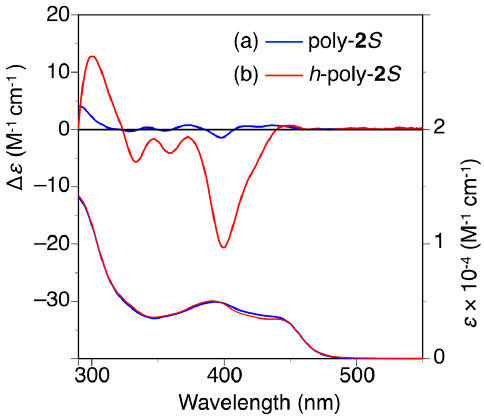
Figure 2. CD and absorption spectra of poly- 2 S ( a ) and h -poly- 2 S ( b ) in N , N -dimethylformamide (DMF) at 25 °C. h -Poly- 2 S was obtained by annealing poly- 2 S in DMF at 120 °C for 2 h. The poly-( 2 S x - co - 3 1 − x )s were converted to the corresponding h -poly-( 2 S x - co - 3 1 − x )s with predominantly one-handed helical conformations in the same way by annealing the corresponding DMF solutions at 120 °C for 2 h. Figure 3 shows the CD and absorption spectra of the h -poly-( 2 S x - co - 3 1–x )s in DMF at 25 °C together with those of h -poly- 2 S . The CD intensities of these polymers ( Δ ε of the first Cotton